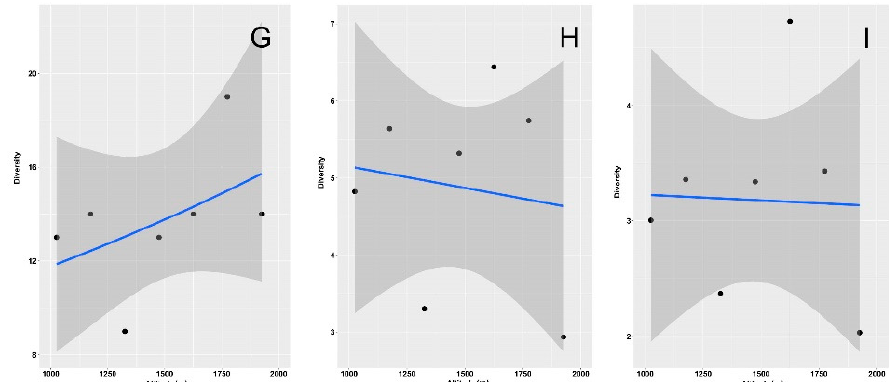
Figure 5. Relationships between aphodiid species richness ( A , D , G ), exponential Shannon diversity ( B , E , H ), and Simpson diversity ( C , F , I ) and altitude along an elevational gradient in central Italy. Curves were constructed using empirical values for the two habitats (woodlands and grasslands) separately (woodlands: A – C ; grasslands: D – F ) and merged ( G – I ). General linear models were used for fitting. Dashed areas are 95% confidence intervals.